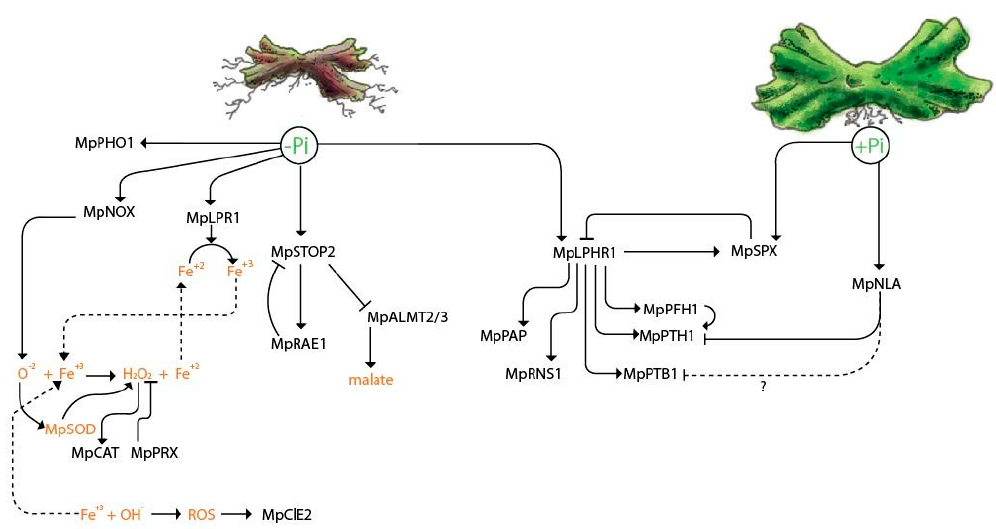
Figure 6. Model of the molecular response of M. polymorpha upon Pi starvation. Under low Pi conditions (left side of the figure), the expression of MpPHO1 is promoted. Mp NOX1 induces the production of superoxide radical (O 2 − ), which is catalyzed by SUPEROXIDE DISMUTASE (Mp SOD ) into hydrogen peroxide (H 2 O 2 ). Hydrogen peroxide is catalyzed by CATALASE (Mp CAT ) into oxygen and water. In addition, the peroxidases (Mp PRX ) use hydrogen peroxide to carry out several reactions. On the other hand, the (O 2 − ) plus Fe 3+ carried out the Fenton–Weiss reaction to produce hydroxyl radical and Fe 2+ . This step coupled to the induction of Mp LPR1 , which is a multicopper oxidase that leads to Fe 3+ from Fe 2+ under low Pi conditions, generates an oxidation–reduction process, and probably impacts thallus development similar to what occurs in A. thaliana root. Here, we observed that the gene encoding the Mp CLE2 peptide is up-regulated in specific times after growth in low Pi conditions—probably to modulate the maintenance and function of the meristem. In addition, during low Pi deficiency, the expression of Mp STOP2 is up-regulated, promoting the expression of its putative negative regulator the F-Box ubiquitin ligase Mp RAE1 . Contrary to previous reports in vascular plants, Mp ALMT2/3 are down-regulated under low Pi conditions. In agreement with this, we hypothesized that low Pi represses the expression of malate transporters to reduce the efflux on soil. On the other hand, the transcription factor Mp PHR1 is induced under low Pi conditions and promotes the expression of MpPAPs and Mp RNS1, which are both genes involved in Pi scavenging. MpPHR1 promotes the expression of both Pi transporters MpPHTs and MpPTBs via the P1BS motives in their promoters. Additionally, we found that the Mp PHF1 , an essential protein for the movement of MpPHT transporters from the ER to the PM, is under the control of Mp PHR1 . In contrast, Mp NLA is expressed in high Pi conditions, leading to the degradation of PHT and probably limitation, we found Mp SPX, which is a negative regulator of Mp PHR1 . MpSPX is up-regulated